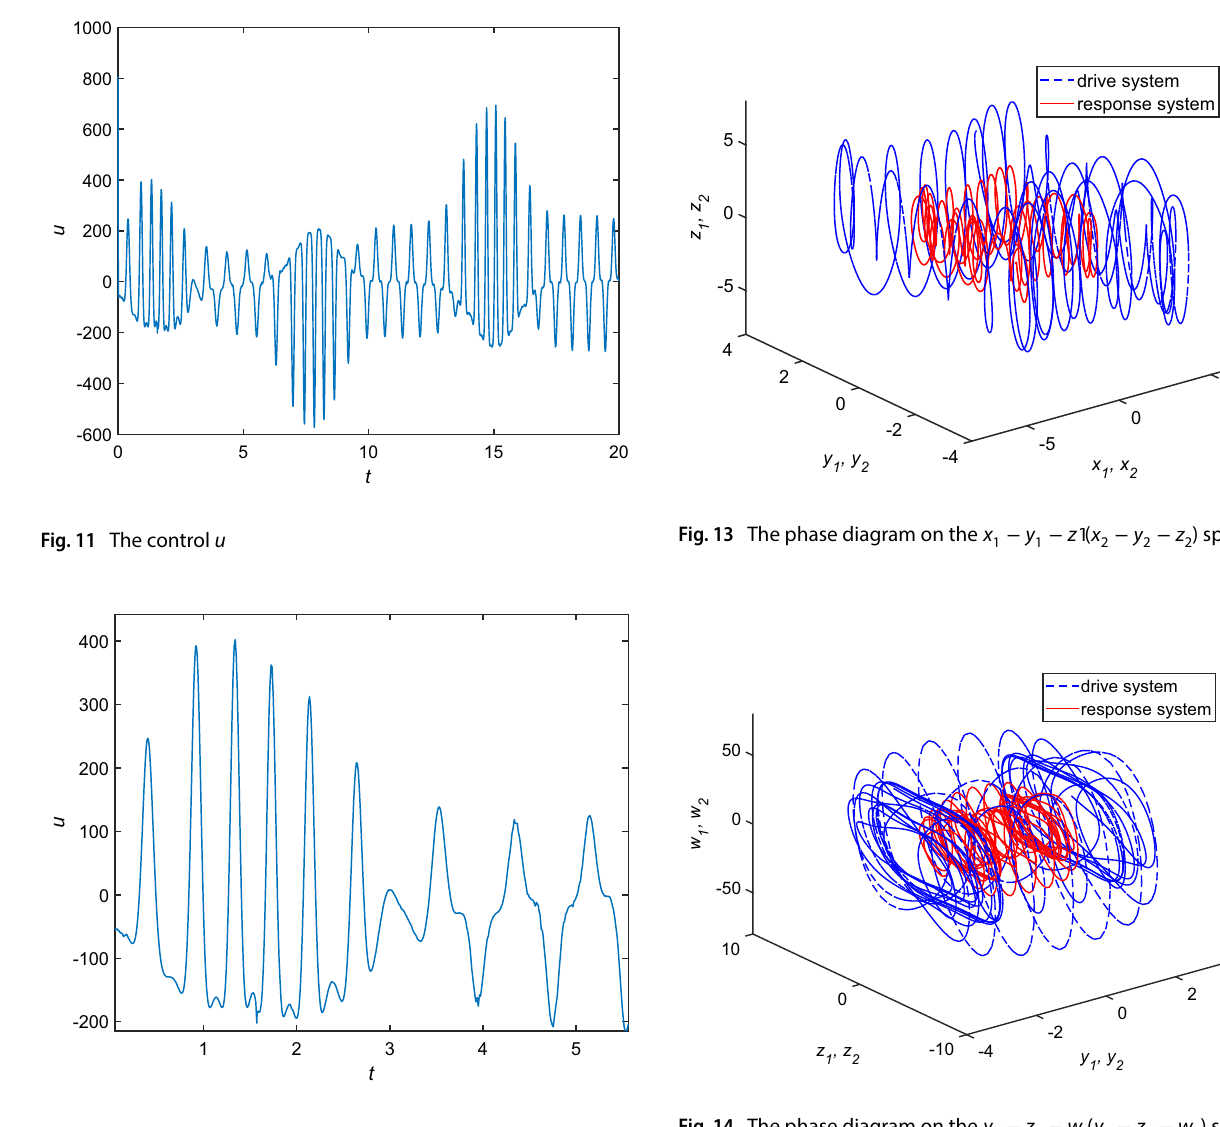
Fig. 14 The phase diagram on the y 1 − z 1 − w 1 ( y 2 − z 2 − w 2 )